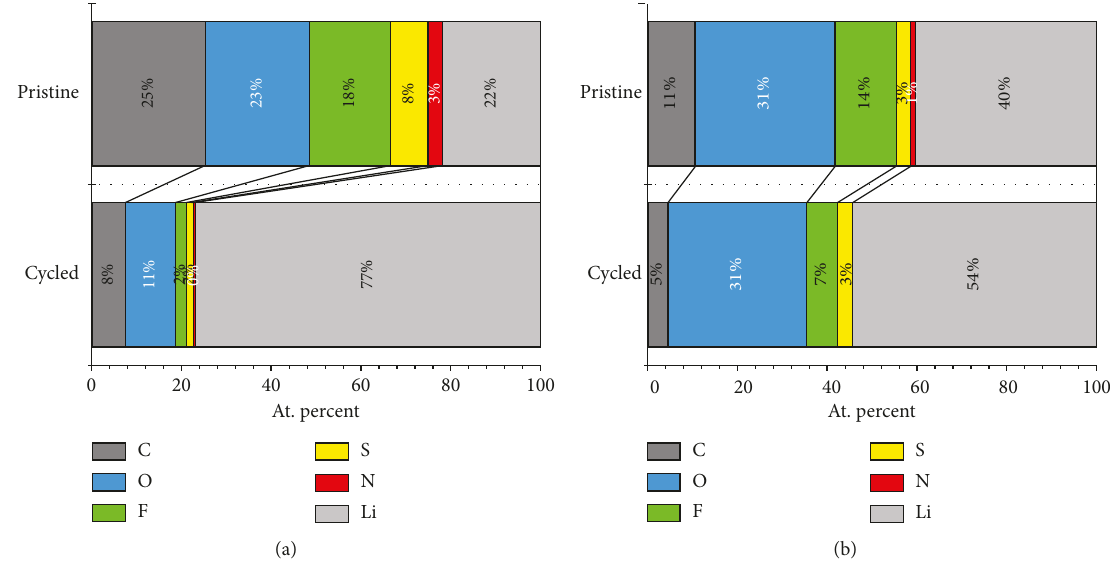
Figure 8: Calculated relative quantities of the elemental composition for the SEI layers after self-passivation and electrochemical cycling in a full Li-S cell with 1M LiTFSI, DOL :TEGDME electrolyte, before (a) and after (b) 30min Ar sputtering time.